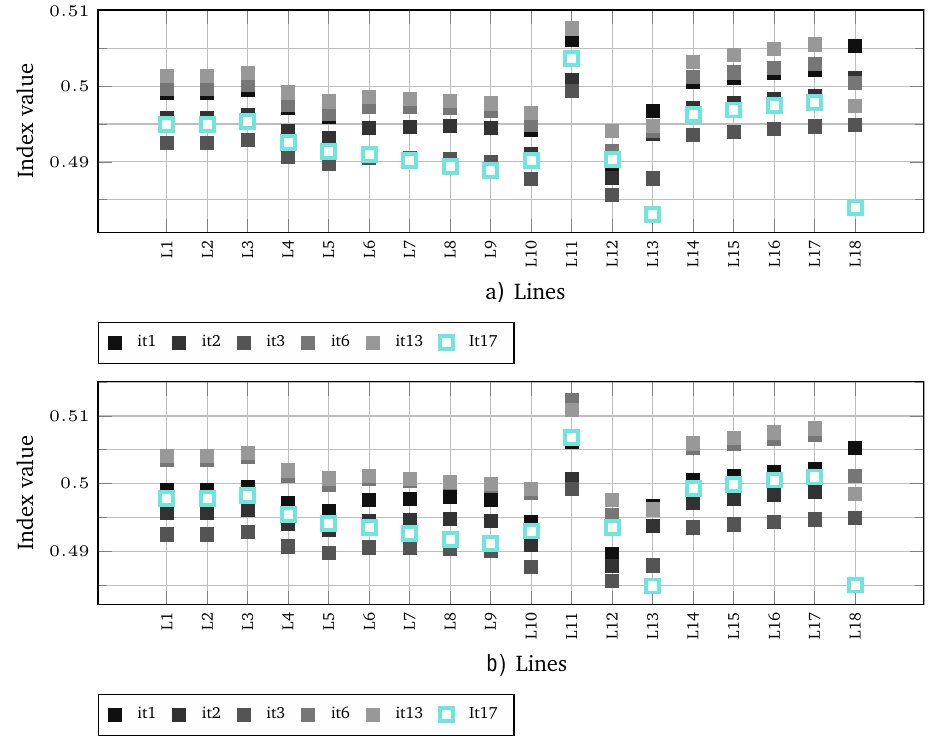
Figure 10. VCPI_1 Index for load case 1. ( a ) Constant load model. ( b ) Frequency-dependent load